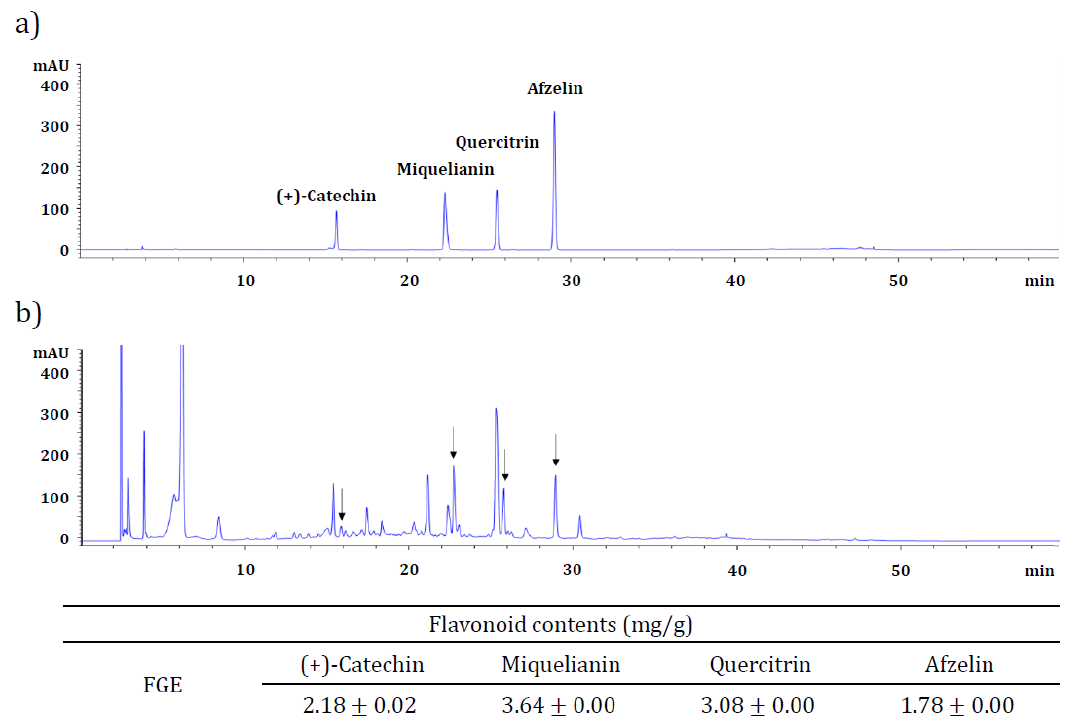
Figure 6. ( a ) HPLC chromatogram of a mixture of four flavonoid references comprising (+)-catechin, miquelianin, quercitrin, and afzelin (250 μg/mL each). ( b ) HPLC chromatogram of FGE (1